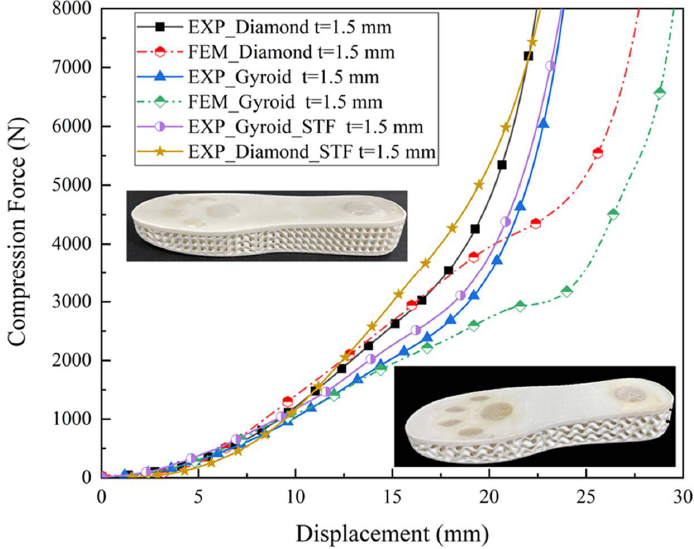
Figure 7. Compression force–displacement curves of Gyroid and Diamond soles of 1.5 mm thickness with and without STF filling.